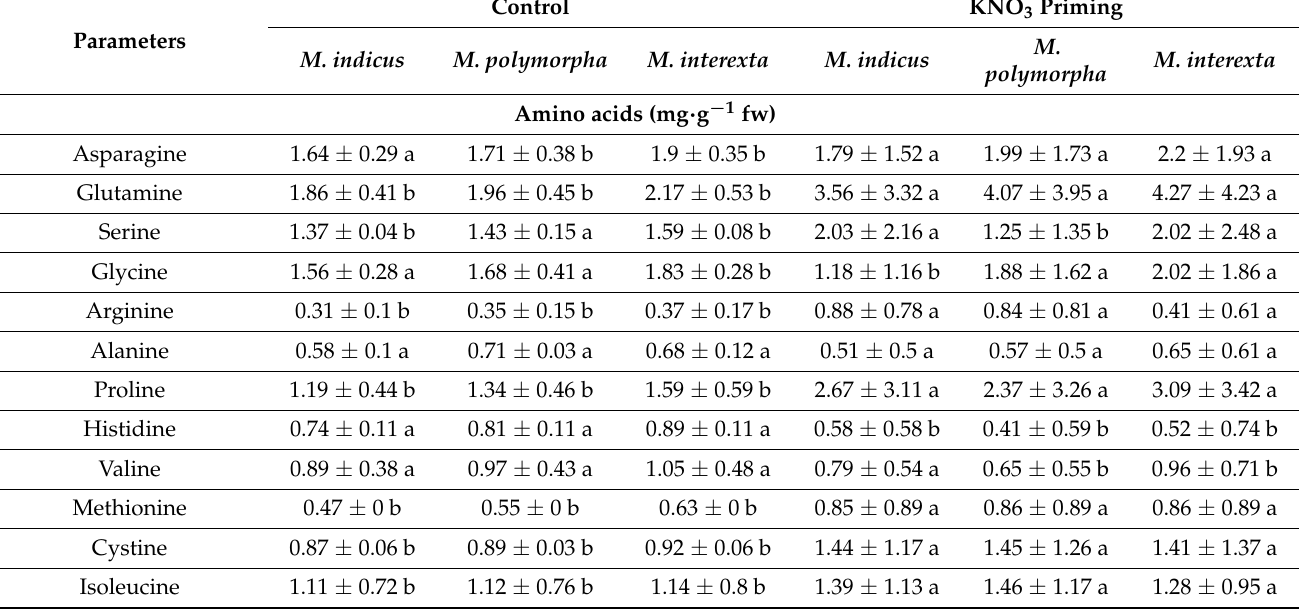
Table 3. Effect of KNO 3 priming on total amino acids content, total N, proteins and NR, GDH and GOGAT activities of three species of Medicago sprouts, Values are represented by mean ± standard deviation of at least three independent replicates, Means marked by different letters are significantly different than control at p <